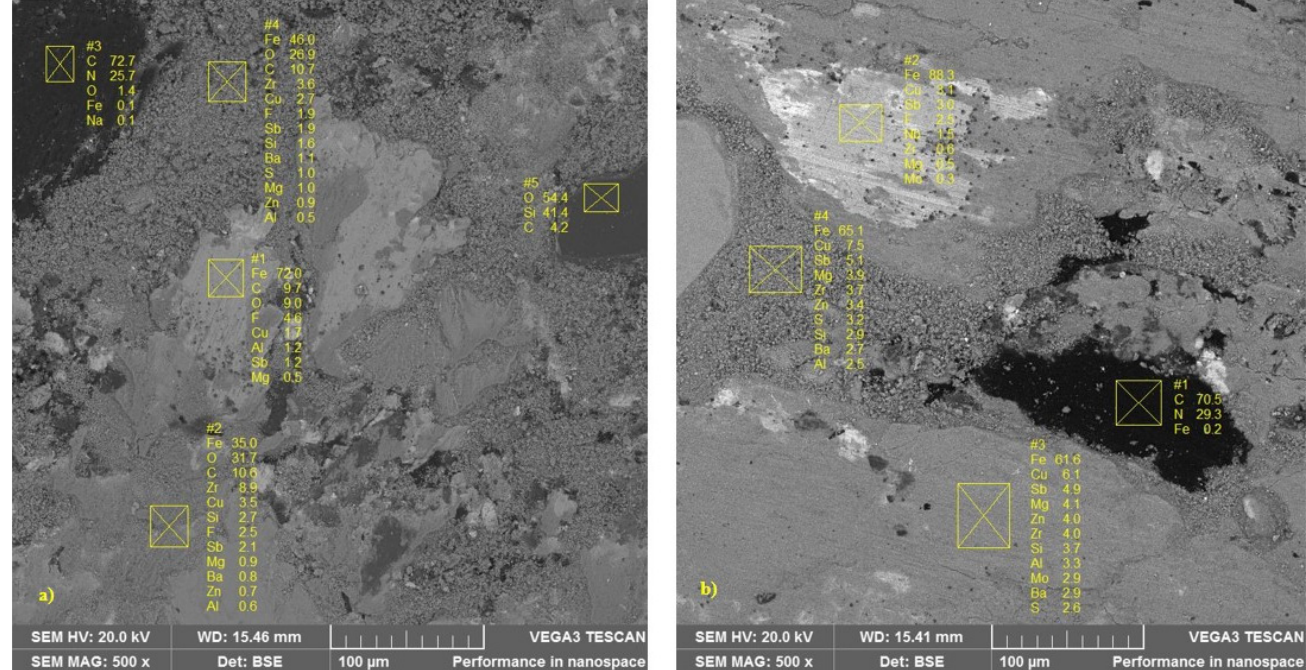
Figure 10. EDS analysis performed at different points: ( a ) simulated downhill; ( b ) emergency braking.